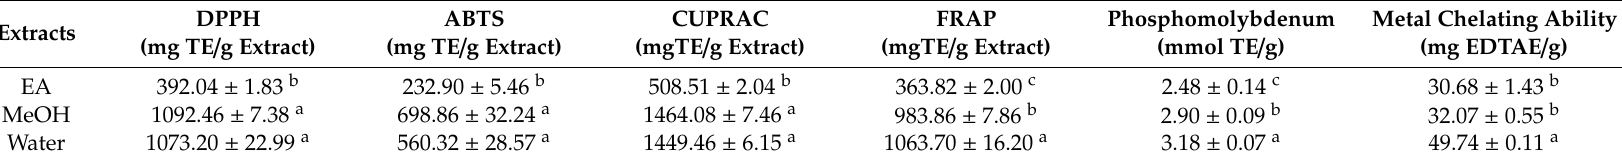
Table 3. Antioxidant activities of the tested